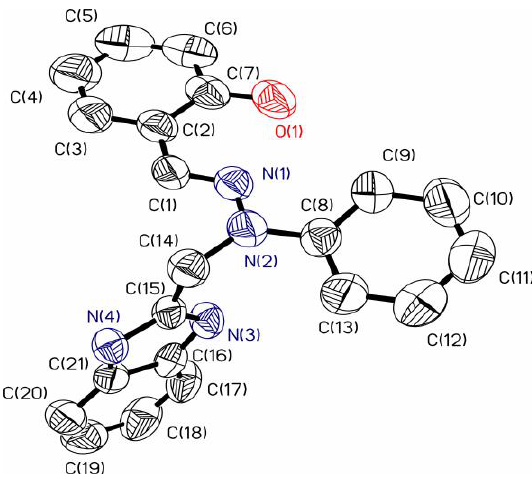
Figure 2. TGA profiles of complexes 1 , 2 , 3 and 4 .